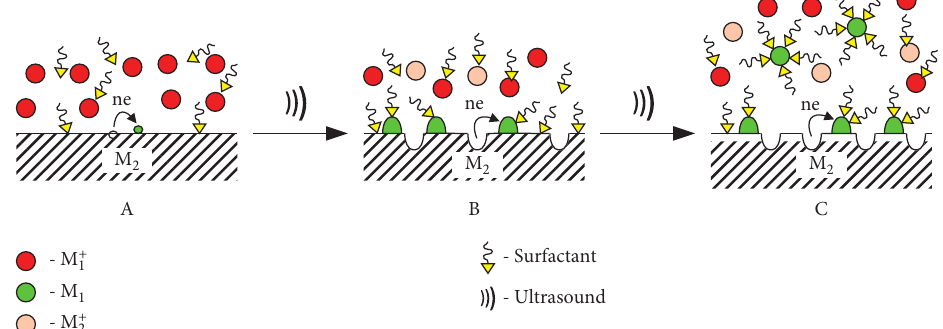
Figure 9: Scheme of MNPs formation by galvanic replacement and ultrasound in solution with surfactant.